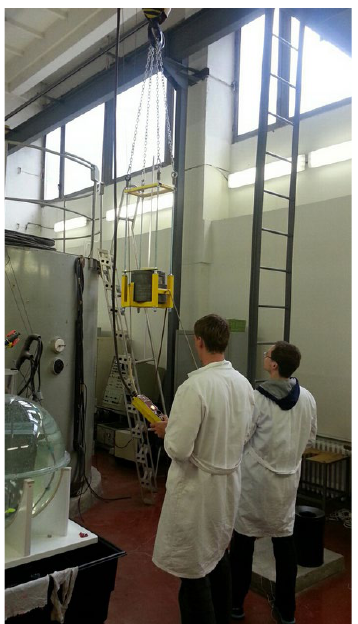
Fig. 2 . Radiation Laboratory, STU, Bratislava.